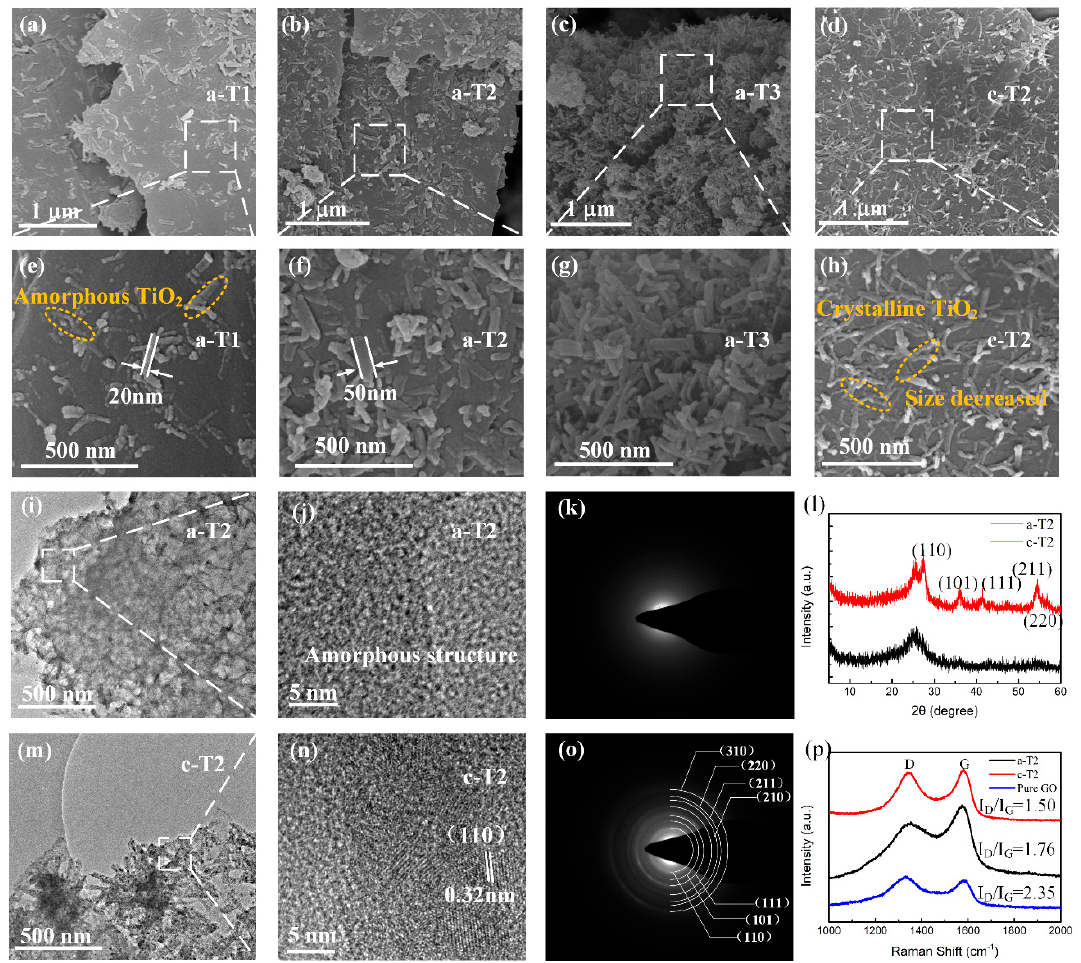
Figure 2. SEM images of ( a , e ) a-T1, ( b , f ) a-T2, ( c , g ) a-T3 and ( d , h ) c-T2; ( i , m ) TEM images, ( j , n ) HRTEM micrographs, ( k , o ) SAED patterns, ( l ) XRD patterns of a-T2 and c-T2; ( p ) Raman spectra of a-T2, c-T2 and pure GO.